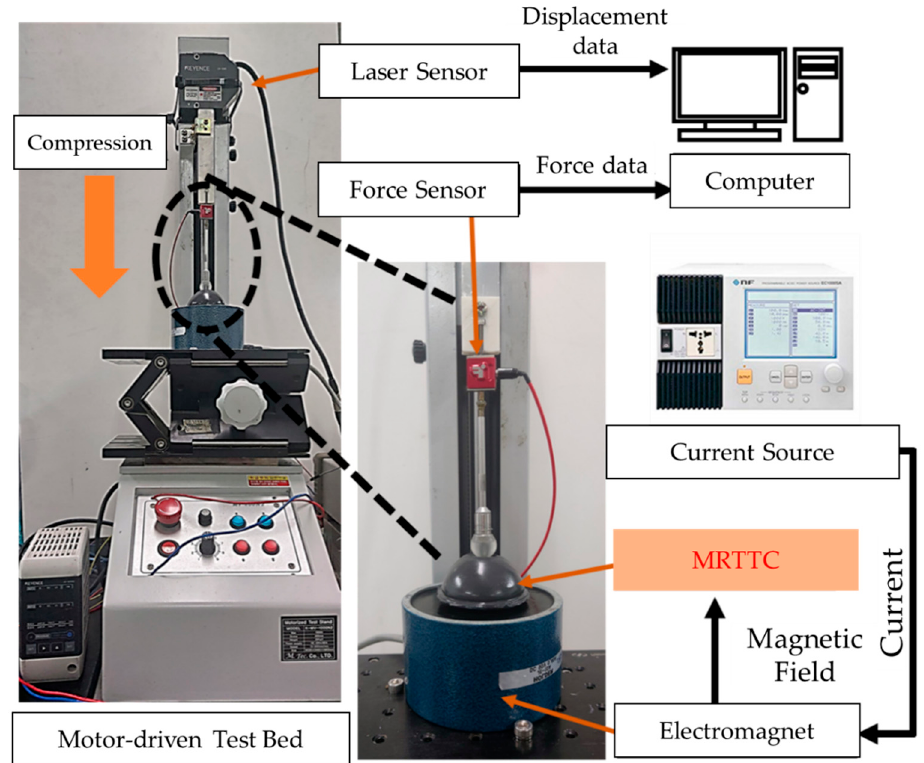
Figure 11. Experimental configuration for the repulsive force measurement of MRTTC. The force sensor installed on the moving piston, as shown in Figure 11 is used to measure the field-dependent repulsive force in the vertical direction at different compres- sive deformation depths. Once we have trained with the proposed MRTTC for feeling a certain repulsive force at the specific current, we can expect a certain repulsive force from been carried out in this work. In short, one can predict a certain repulsive force at a specific input current after training and the force can be compared with the one measured from the force